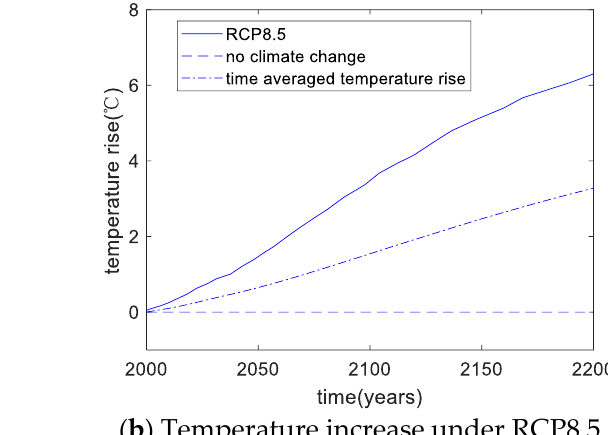
Figure 6. Increases in CO 2 concentration and temperature under RCP8.5.